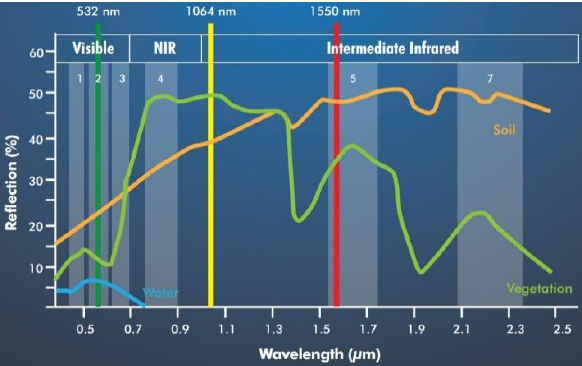
Figure 1. Lidar wavelength sensitivities for a broad spectrum